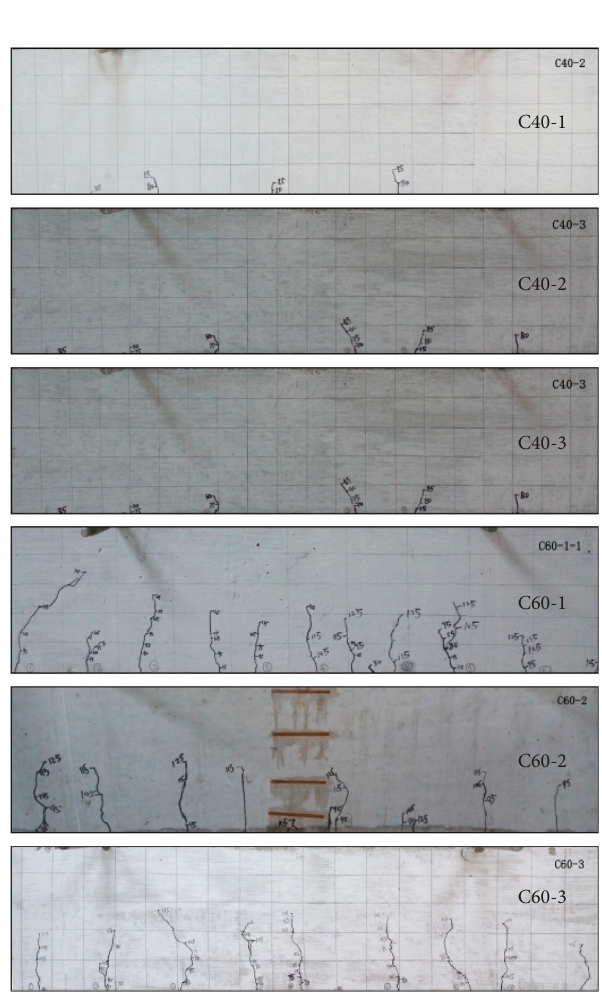
Figure 2: Initial cracks on the PC beams after